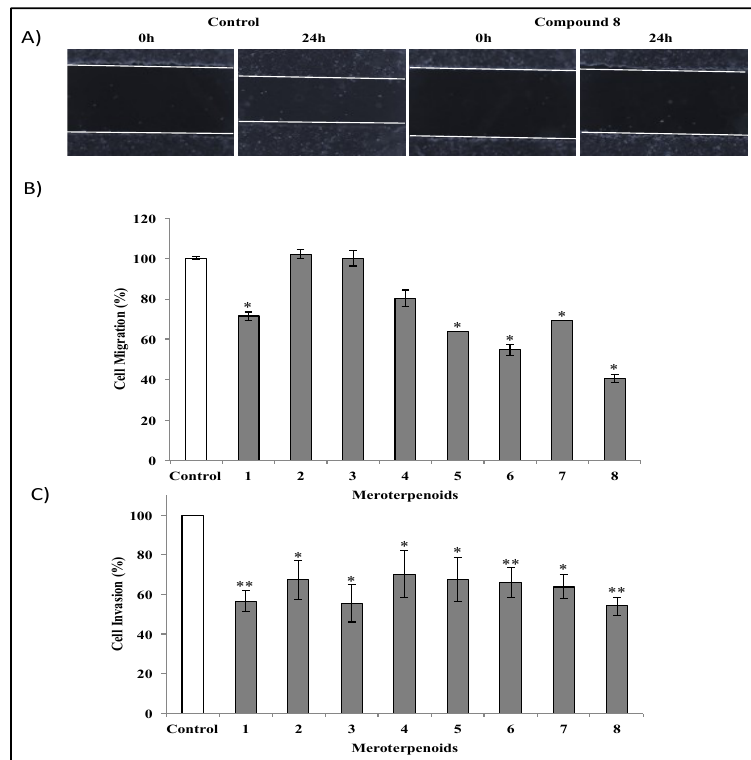
Figure 5. Effects of meroterpenes (AMTs) 1-8 on migration and invasion of HT-29 cells. ( A ) Seeded colon cancer cells were wounded and imaged (0 h). Untreated HT-29 cells and cells treated with compound 8 (10 µg/mL) were incubated for 24 h. ( B ) Bar charts show migrated HT-29 cells after treatment for 24 h with 1 , 2 , 5 , 6 , 7 , and 8 at 10 µg/mL and with 3 and 4 at 30 µg/mL. ( C ) Anti-invasive activity of AMTs against HT-29 cells measured using a Cultrex assay kit. HT-29 cells were untreated or treated for 24 h with 1 , 2 , 5 , 6 , 7 , and 8 at 10 µg/mL and with 3 and 4 at 30  g/mL. The result of control groups was set as 100% activity and test groups were compared to this value. The data represent the means ± SE of three independent experiments. Significant differences to control group: * p < 0.05 and ** p < 0.01. 3.5. The AMTs 1 - 8 Inhibit Phosphorylation of ERK, JNK, and